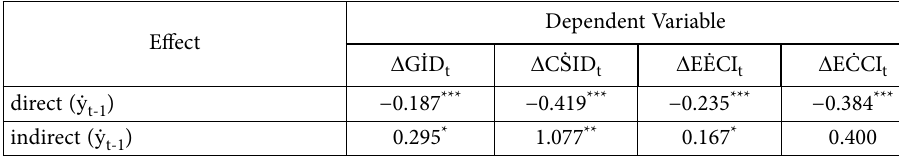
Table 4. Direct and indirect effects of lagged detailed indicators